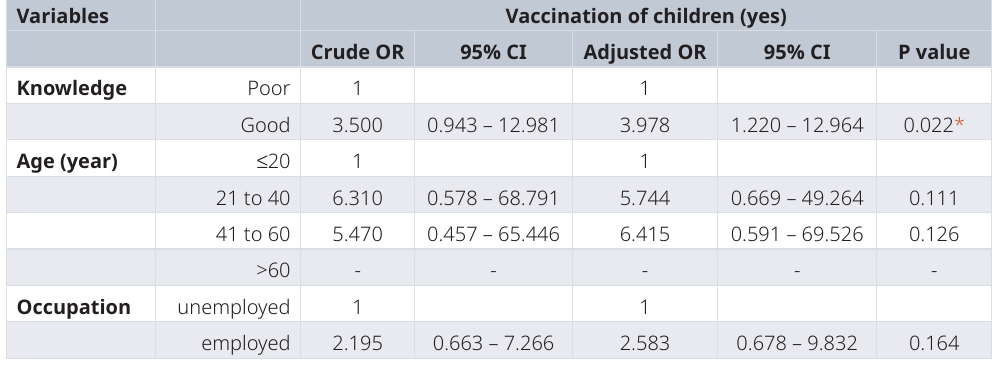
Table 4. Respondent level factors associated with vaccination against JE among children in Yangon region, Myanmar